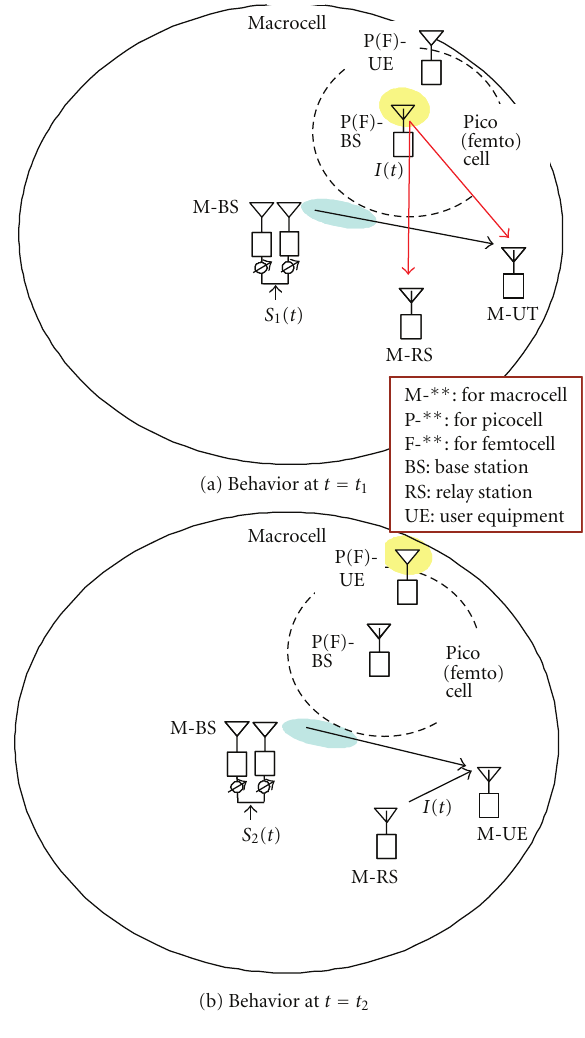
Figure 3: Concept of proposed